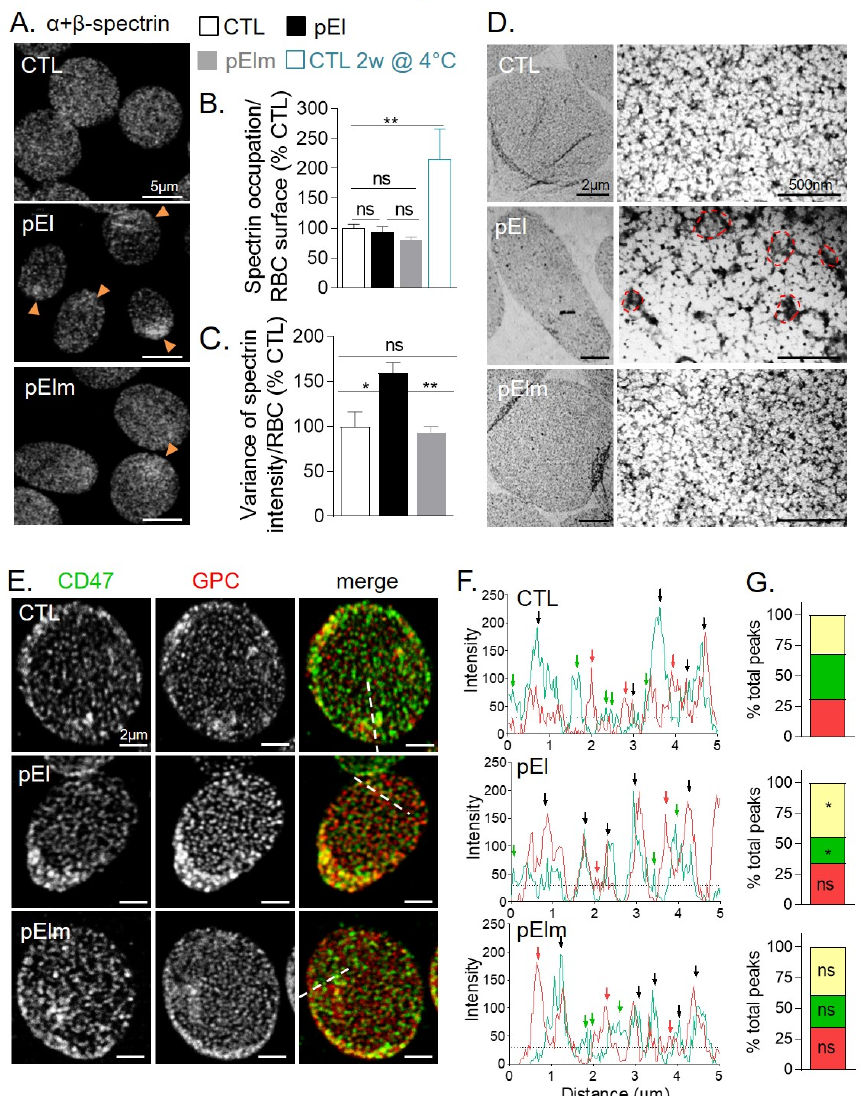
Figure 2. The spectrin network in patient pEl RBCs was heterogeneously distributed and the two membrane anchorage complexes were less segregated than in RBCs from healthy individuals and pElm. ( A – D ) Spectrin network analyzed by confocal ( A – C ) and transmission electron microscopy ( D ). RBCs were laid down on poly-L-lysine (PLL)-precoated coverslips ( A – C ) or formvar coated grids ( D ), permeabilized with 0.5% ( w/v ) Triton X-100, fixed and stained with anti-pan spectrin antibodies ( A – C ) or not ( D ). ( A , D ) Representative images. Orange arrowheads at A and red areas at D point to increased cytoskeleton density. ( B , C ) Quantification of spectrin occupation and dispersion on confocal images. 2 week-stored RBCs were used as internal control. Data are expressed by reference to the mean of control RBCs from the same experiment and are means ± SEM from 3–5 independent experiments with 50–150 RBCs measured/condition. Ordinary one-way Anova followed by Turkey’s multiple comparisons test. ( E – G ) Membrane protein distribution determined by confocal imaging. RBCs were laid down on PLL-precoated coverslips, fixed and stained with antibodies against CD47 (ankyrin complexes; green) and glycophorin C (GPC; 4.1R complexes; red). ( E ) Representative images. ( F ) Representative intensity profiles along the paths indicated at E by white dotted lines. Green arrows, CD47 only; red arrows, GPC only; black arrows, CD47 / GPC overlapping. ( G ) Quantification of the abundance of CD47, GPC and CD47 / GPC-overlapping peaks (yellow portion of the columns) determined on 30–40 profiles per condition generated from 4–5 independent experiments (expressed as percentage of total peaks from all the profiles). Unpaired t -tests were used to compare the proportion of yellow, green and red peaks between the CTL and the patient or her mother. ns, not significant; * , p < 0.05; ** , p <